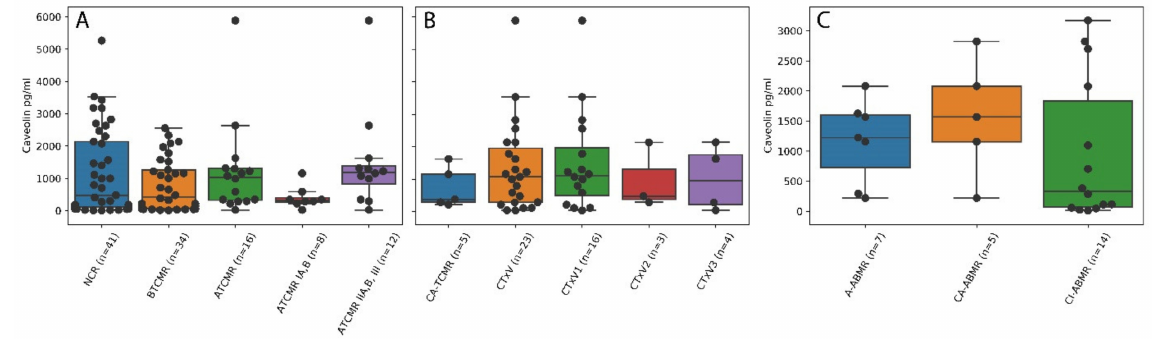
Figure 2. Overview of Banff categories/grades compared to Cav-1 serum levels. Boxes correspond to the 25% and 75% percentile, median line inside the box, whiskers display the rest of the distribution, outliers are outside the whiskers. ( A ) Acute cellular rejections: NCR = no cellular rejection; BTCMR = borderline (suspicious for) T-cell mediated rejection; ATCMR = acute T-cell mediated rejection; ATCMR IA,B = acute T-cell mediated rejection of grade IA,B (tubulointerstitial rejection); ATCMR IIA,B,III = acute T-cell mediated rejection of grade IIA,B,III (cellular vascular rejection). Values were available from all 91 patients. ( B ) Chronic damage: CA-TCMR = chronic and active T-cell mediated rejection (values were available from 46 patients); CTxV = chronic transplantation vasculopathy (cumulative and separated by intensity of fibrointimal narrowing from low/CTxV1 to high/CTxV3; values were available from 89 patients). ( C ) Antibody mediated rejection: A-ABMR = acute antibody mediated rejection; CA-ABMR = chronic active antibody mediated rejection; CI-ABMR = chronic inactive antibody mediated rejection. Values were available from 62